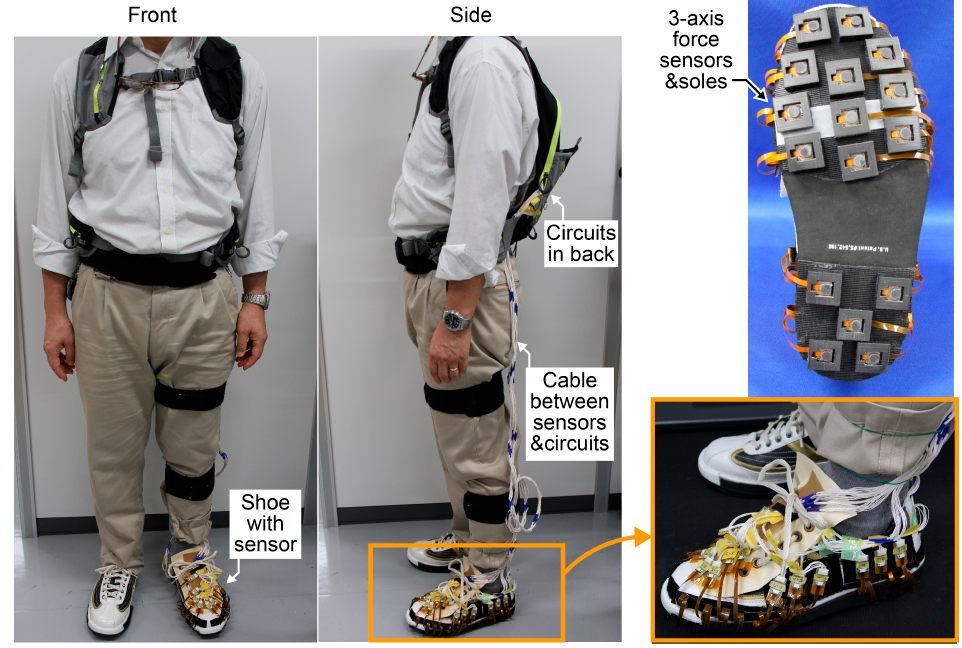
Figure 3. Shoe with three-axis force sensors and appearance of the person who wore the measurement